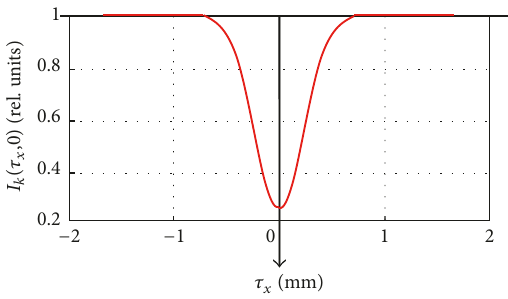
Figure 11: Graph of the change in the collector’s current when the electron beam intersects the penetration channel as it moves along the 𝑥 .